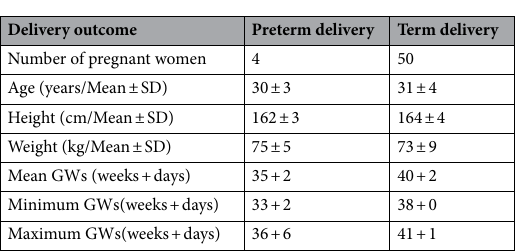
Table 4. Basic information of pregnant women. SD: standard deviation.